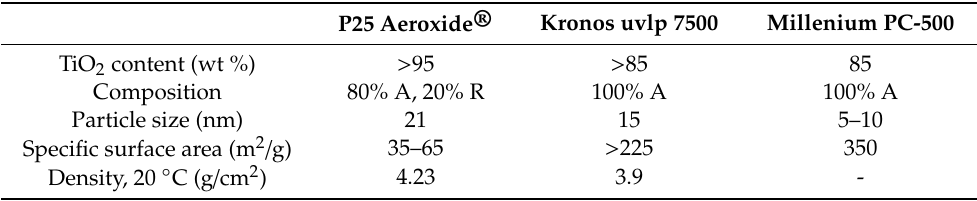
Table 2. Main characteristics of the used TiO 2 catalysts according to the manufacturer’s